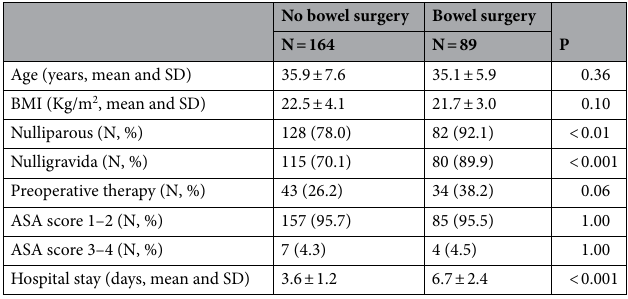
Table 1. Patient characteristics in the two groups.